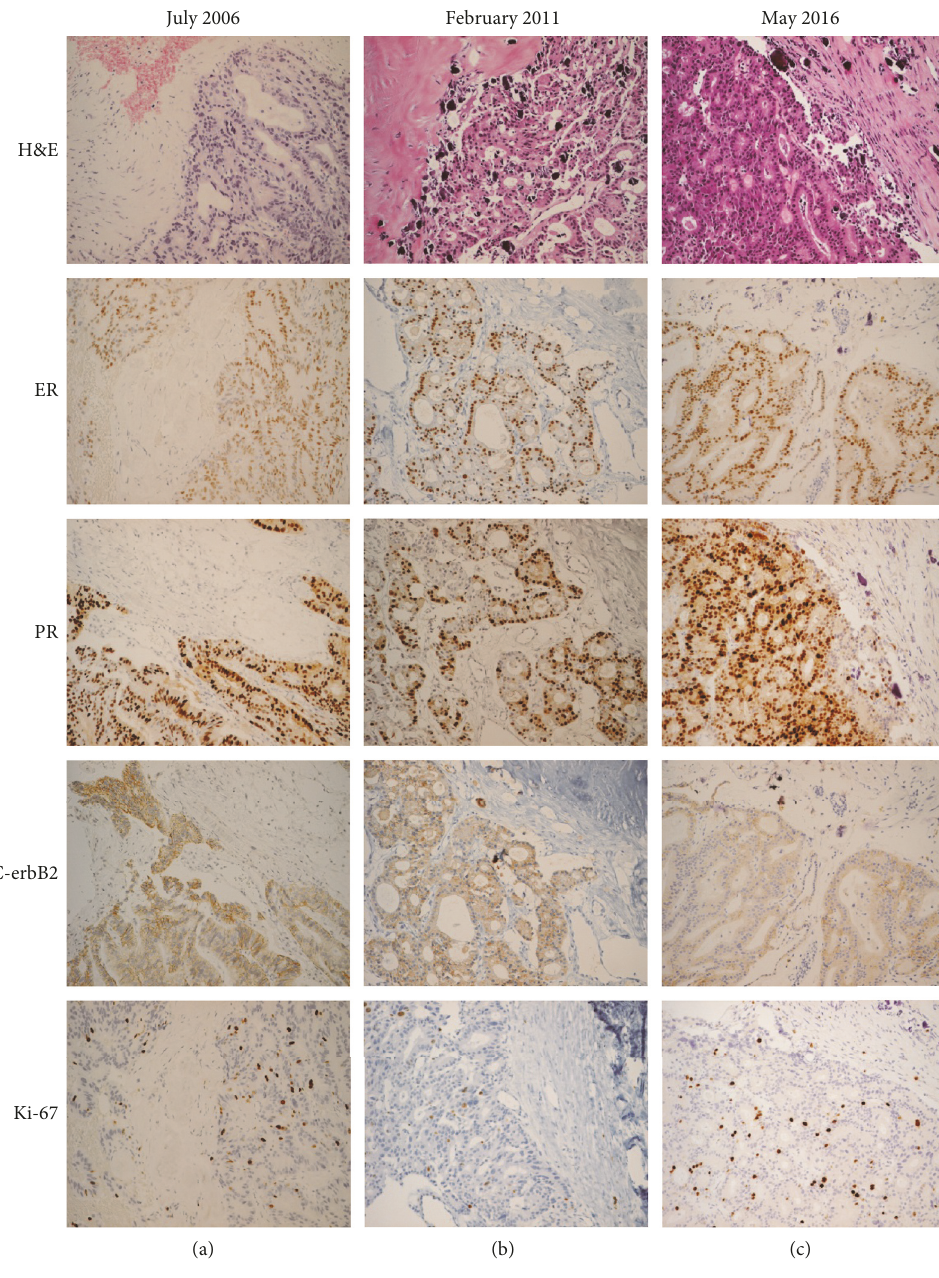
Figure 2: (a–c) Unaltered immunohistochemistry (ER/PR/C-erbB2/Ki-67) as an independent prognostic factor (LM, × 200). H&E: hematoxylin and eosin; ER: estrogen receptor; PR: progesterone